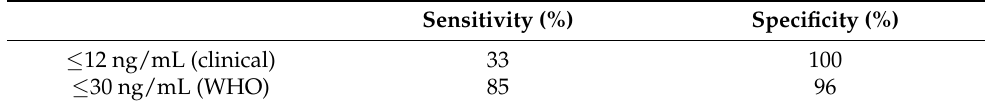
Table 3. Identification of iron deficiency ( n = 44) 1 .